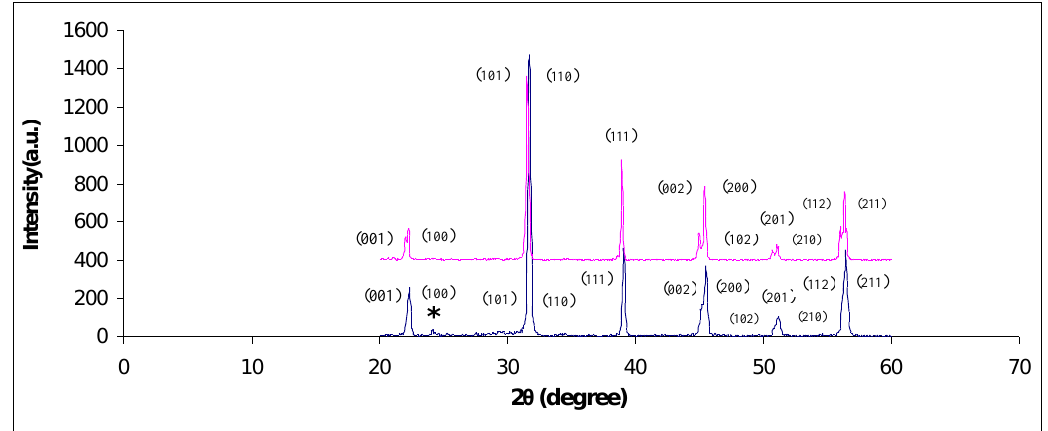
Fig. 7: XRD patterns for pure barium titanate (a) at 1000 ° C and (b) at 1400 ° C.